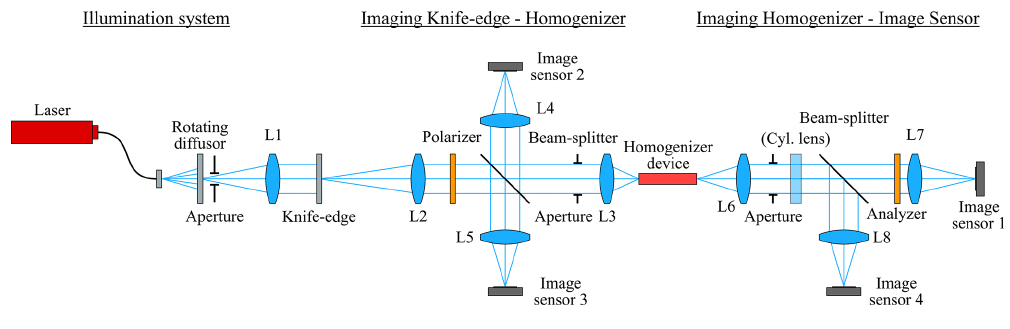
Figure 6. Setup for the near-field measurements.